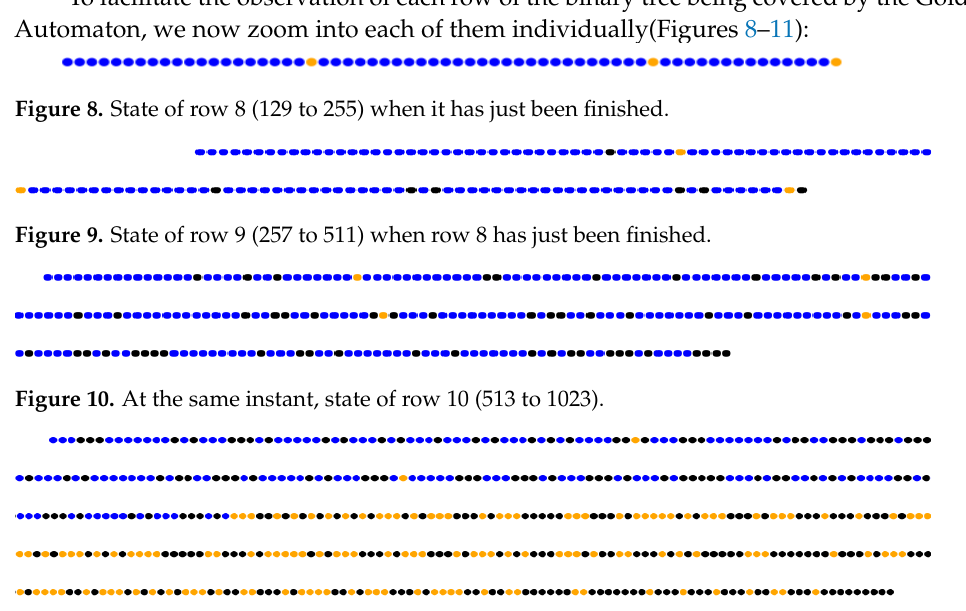
Figure 11. At the same instant, state of row 11 (going from 1025 to 2047: each line has about 100